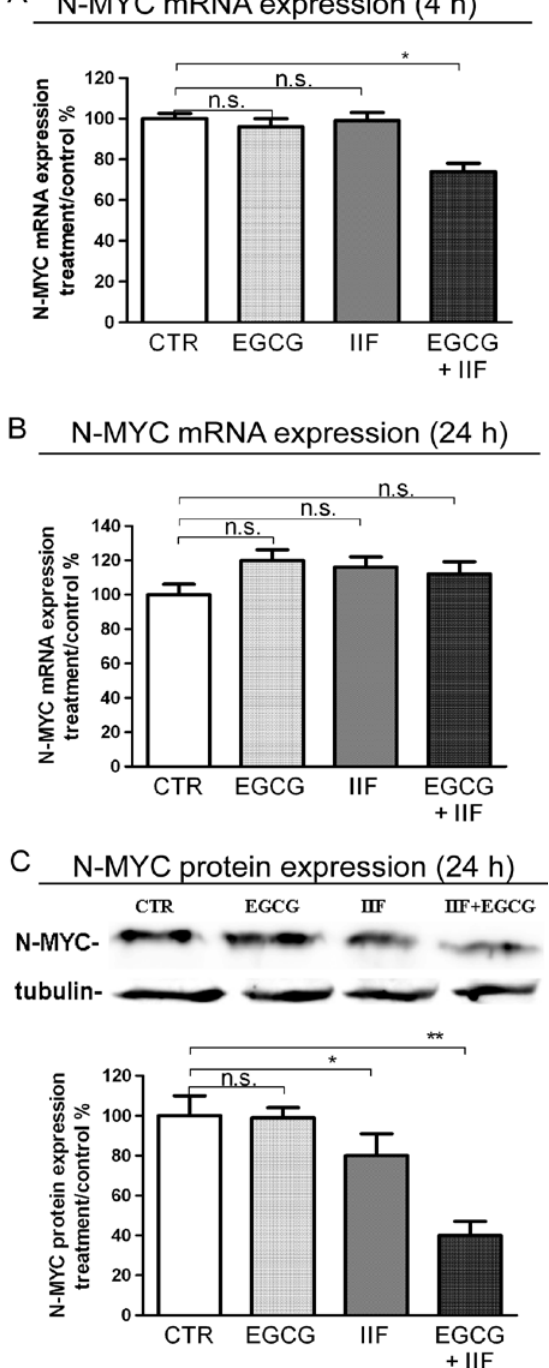
Figure 5. Downregulation of N-MYC expression by EGCG and IIF treatments in BE(2)-C neuroblastoma cells. Cells were treated with 20 µ g/mL EGCG and 10 µ M IIF, individually and in combination. N-MYC qPCR analysis in control and treated cells after 4 h ( A ) and 24 h ( B ). GAPDH was used as a control. ( C ) Proteins (50 µ g) from total cell lysates were subjected to SDS–PAGE and Western blot analysis of N-MYC expression after 24 h treatments. The values were normalized to the untreated controls. β -tubulin was used as a loading control. The results are expressed as the average ± SE of three independent experiments. * p < 0.05; ** p < 0.01. n.s.: not significant. GAPDH: Glyceraldehyde 3-phosphate dehydrogenase.